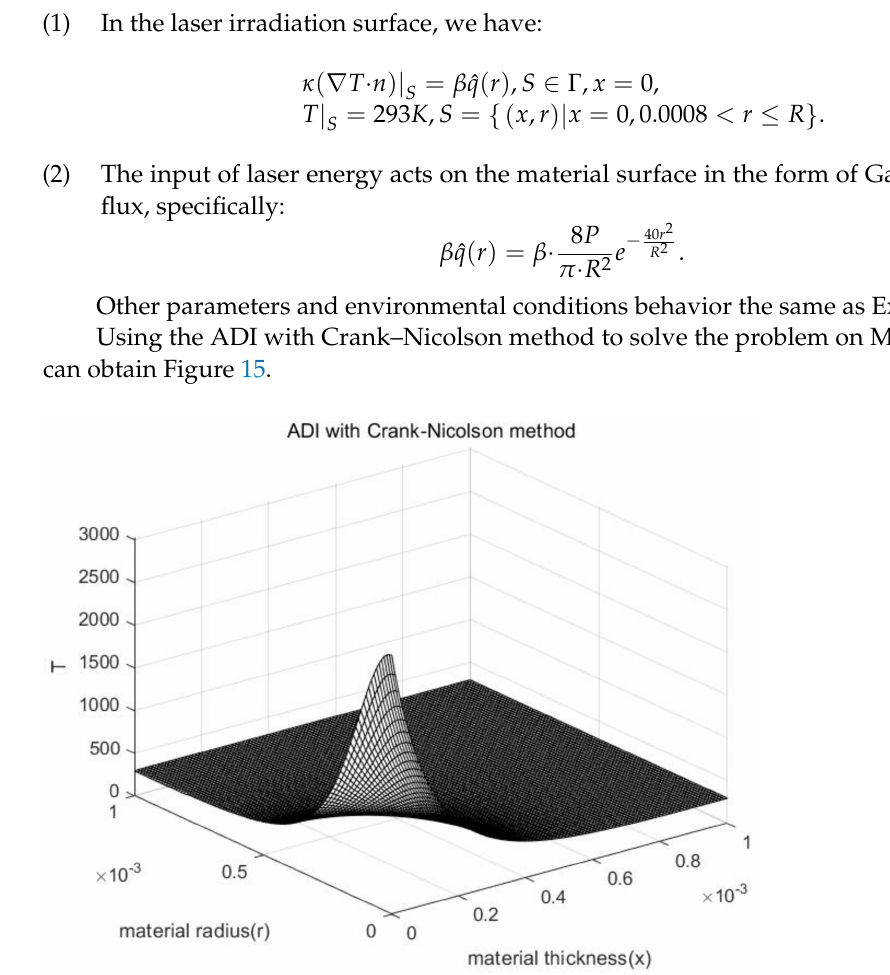
Figure 15. Numerical solutions of difference equations ( h = 0.001 / 100, τ = 0.01 / 500, H = 1.5 )